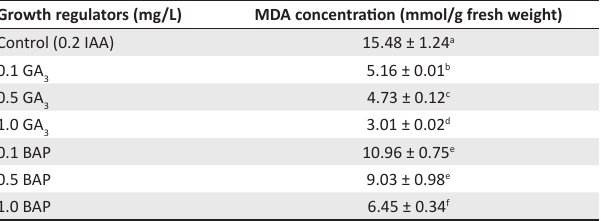
TABLE 1: Effect of different concentrations of gibberellic acid and benzyl aminopurine in combination with indole acetic acid in Murashige and Skoog medium on percentage response of O. gratissimum explants after 28 days of culture.